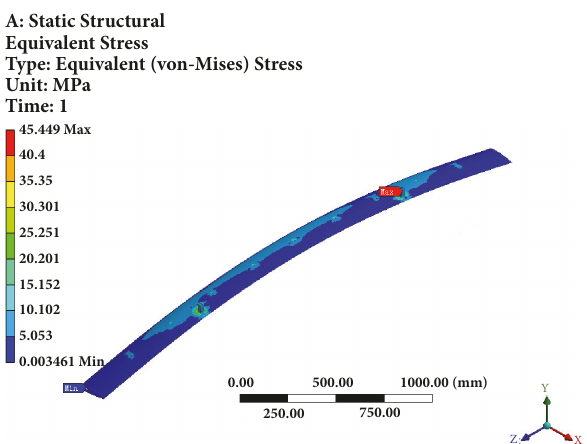
Figure 5: Equivalent stress contour of main blade.